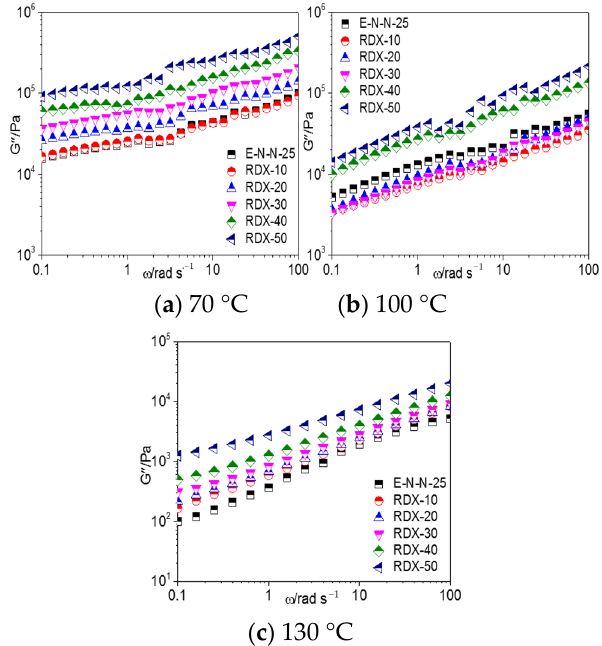
Figure 9. G ″ – ω curves of model propellant at ( a ) 70 °C, ( b ) 100 °C, and ( c ) 130 °C.